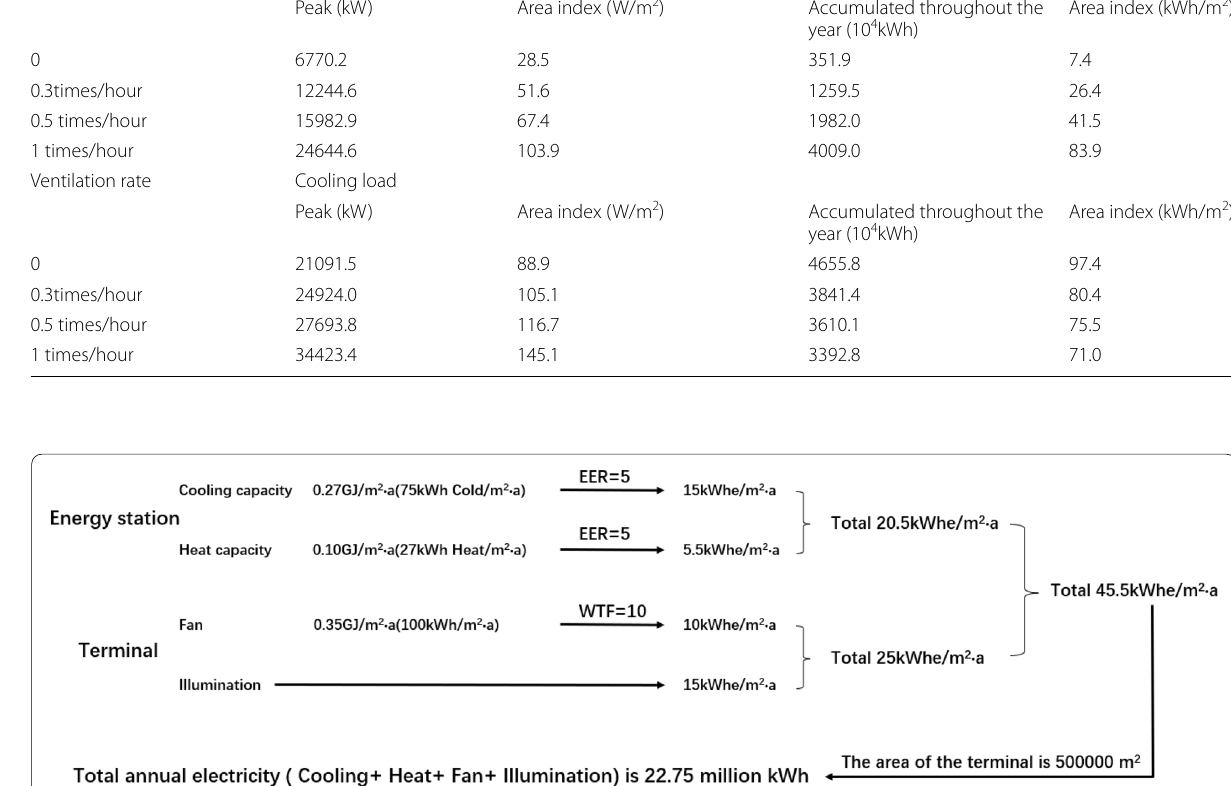
Table 1 Simulation results of the DeST load in the airport area Ventilation rate